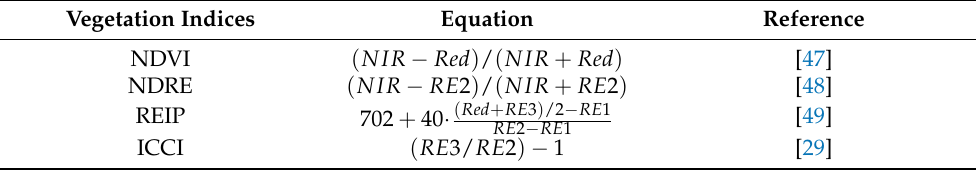
Table 1. Vegetation indices used in the study: normalized difference vegetation index (NDVI), Normalized difference red-edge (NDRE), red-edge inflection point (REIP), and red-edge canopy chlorophyll index (ICCI). Band numbers are indicated in Table 2.